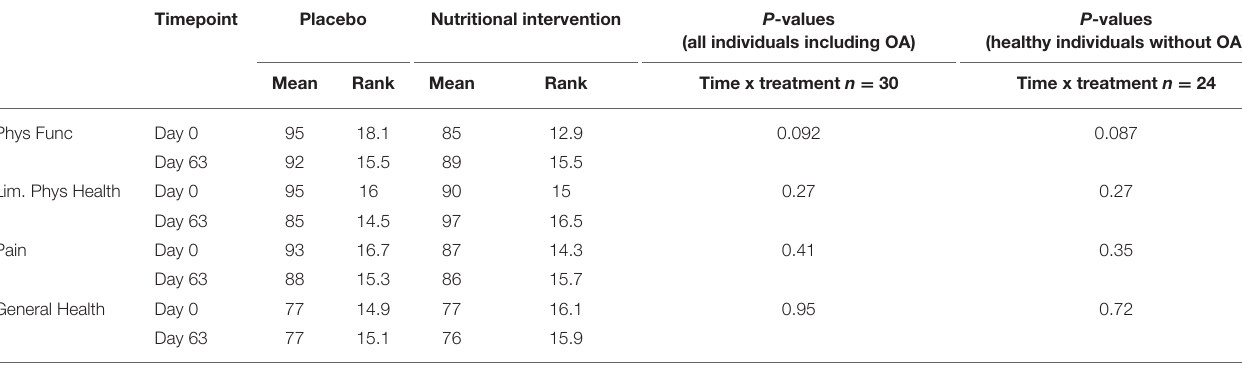
TABLE 4 | Mean scores and ranks for placebo and nutritional intervention group based on the RAND-36 questionaire. P -values Timepoint Placebo Nutritional intervention P -values (all individuals including OA) (healthy individuals without OA) Mean Rank Mean Rank Time x treatment n = 30 Time x treatment n = 24 Phys